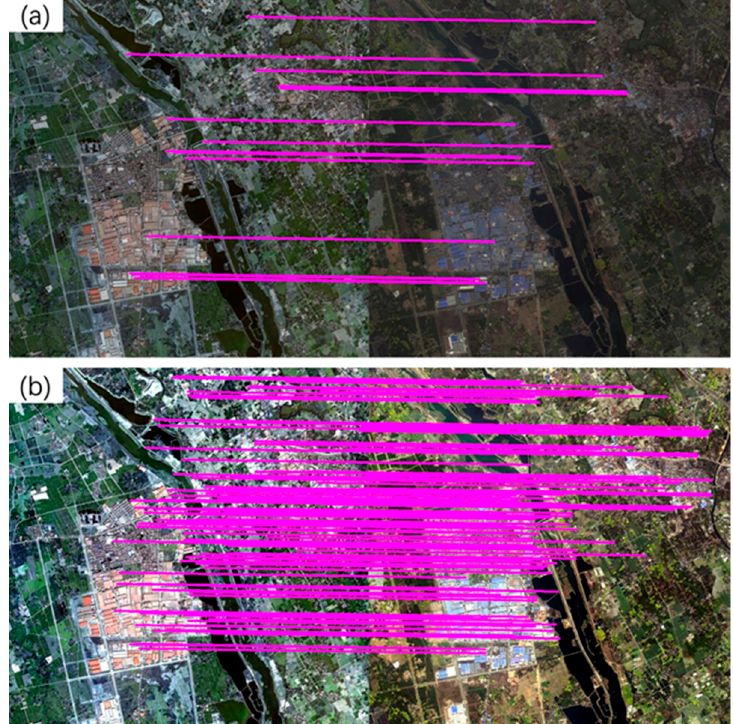
Figure 2. Tie points obtained using the original multispectral image ( a ) and the enhanced image obtained using the 2% linear stretch method ( b ).